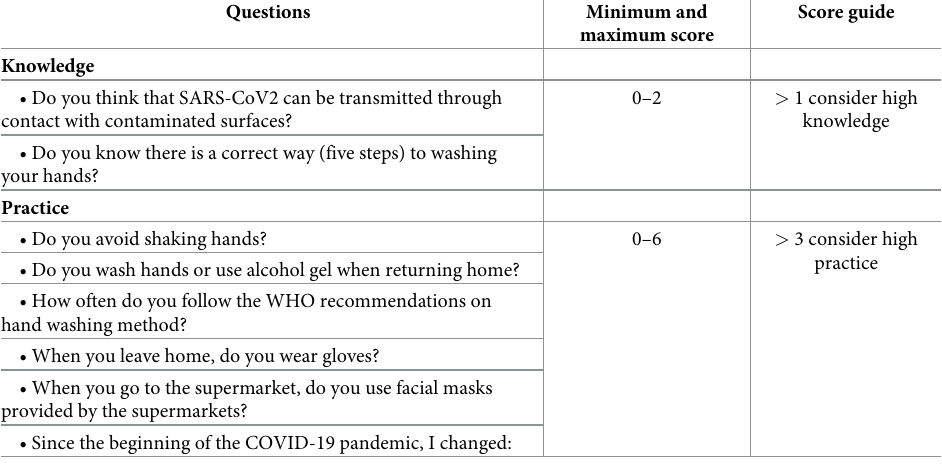
Table 1. Scoring scale and interpretation guidelines for responses to questions that are assessing knowledge and practice of